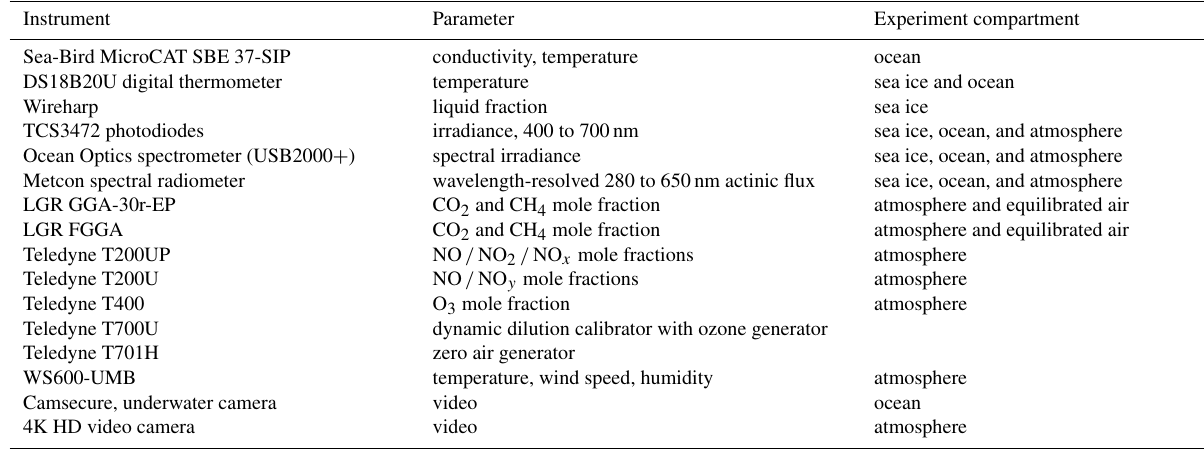
Figure 3. Scaled schematic diagram of the cold room. The three panels show orthogonal views from different vantage points. Crosses and dots indicate air flow away from and towards the viewer, respectively. The lights, shown in grey, are made up of eight sets of visible, UV-A, and UV-B triplets. The main and side tanks are pale green. Table 1. Instruments that are generally available in the